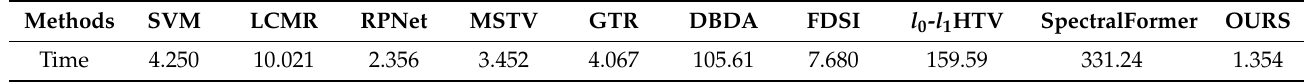
Table 3. The computing time (seconds) of different methods for Indian